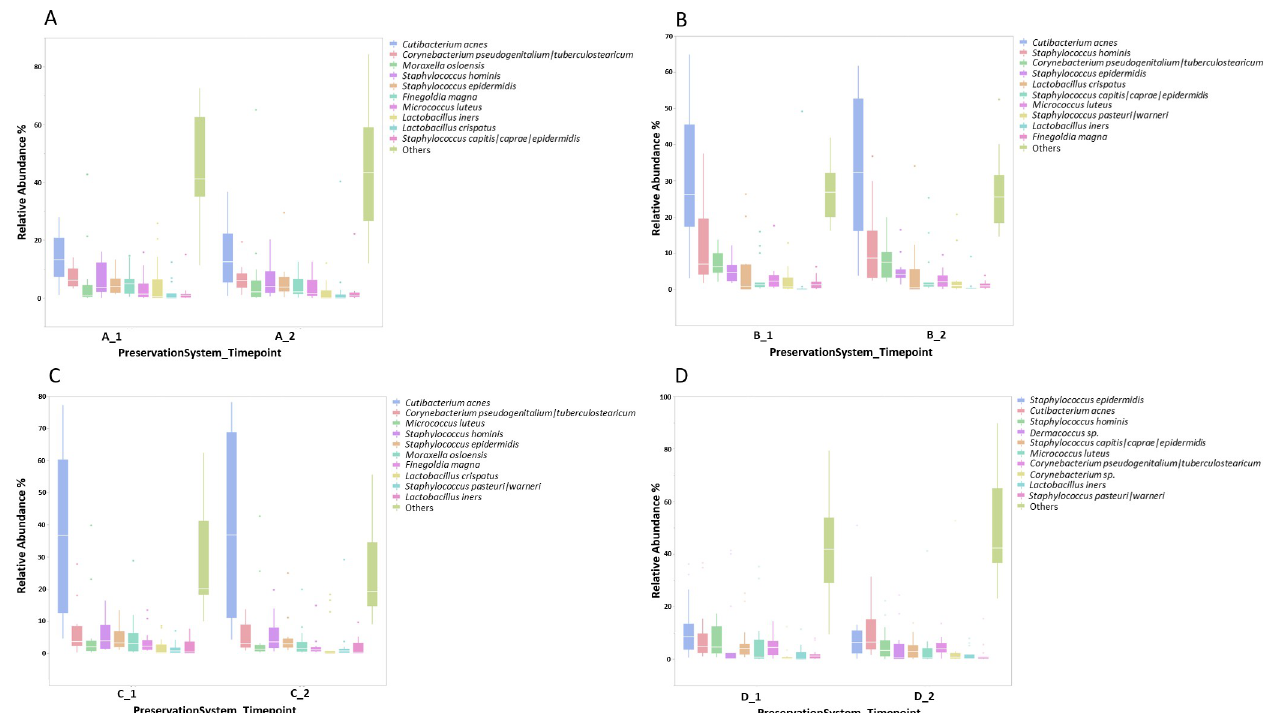
Fig 1. Taxonomic analysis of leg skin microbiome before and after formulation application. Species level taxonomic analysis of leg skin microbiome at baseline (T1) and following product application (T2). Panels A-D correspond to preservation systems A-D and show the top 10 most abundant species in each study.